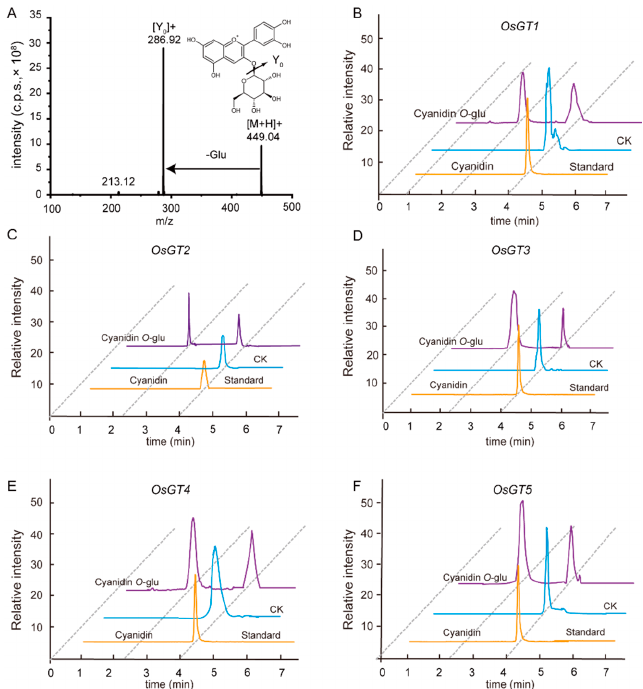
Figure 5. Analysis of the in vitro enzyme activity of OsGTs. ( A ) MS/MS spectra information of cyanidin-3- O -glucoside with the authentic standard. The reactions were performed with 5 purified OsGTs, UDP-glucose, and cyanidin as substrates: GT1, glucosyltransferase 1 ( B ); GT2, glucosyltransferase 2 ( C ); GT3, glucosyltransferase 3 ( D ); GT4, glucosyltransferase 4 ( E ); GT5, glucosyltransferase 5 ( F